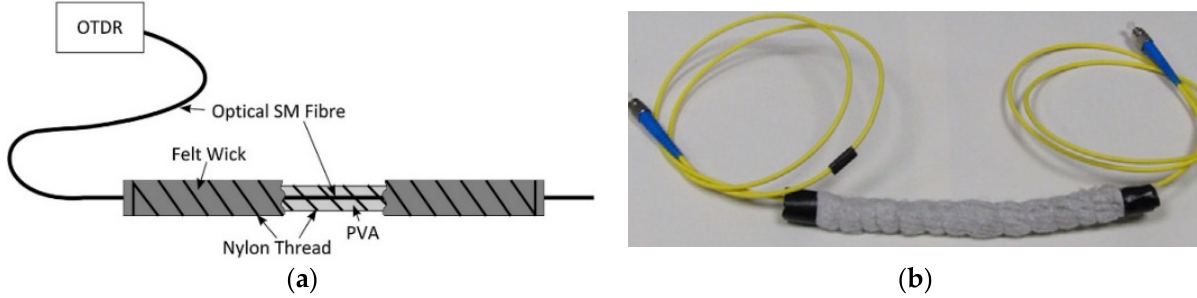
Figure 11. A fiber optic leakage sensor that is based on the micro-bend principle: An optical glass fiber and a PVA rod were bonded together using a nylon thread and covered by a felt wick. When the sensor is exposed to water, the PVA swells and presses the optical glass fiber against the nylon thread and thus induces attenuation of light. ( a ) Schematic of the FOS; Reprinted with permission from Ref. [54]. Copyright 2014 Sensors and Actuators A: Physical. ( b ) Picture of the manufactured FOS; Reprinted with permission from Refs. [54,68]. Copyright 2014 Sensors and Actuators A: Physical and Copyright 2016 Procedia